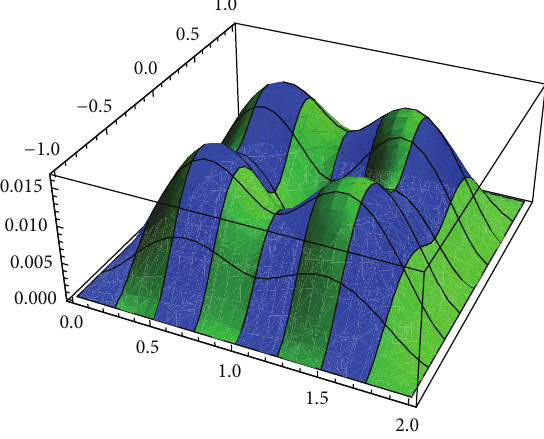
fixed interpolation conditions. Also, the introduced spline could approximate to the interpolated function better than the standard cubic Hermite interpolation